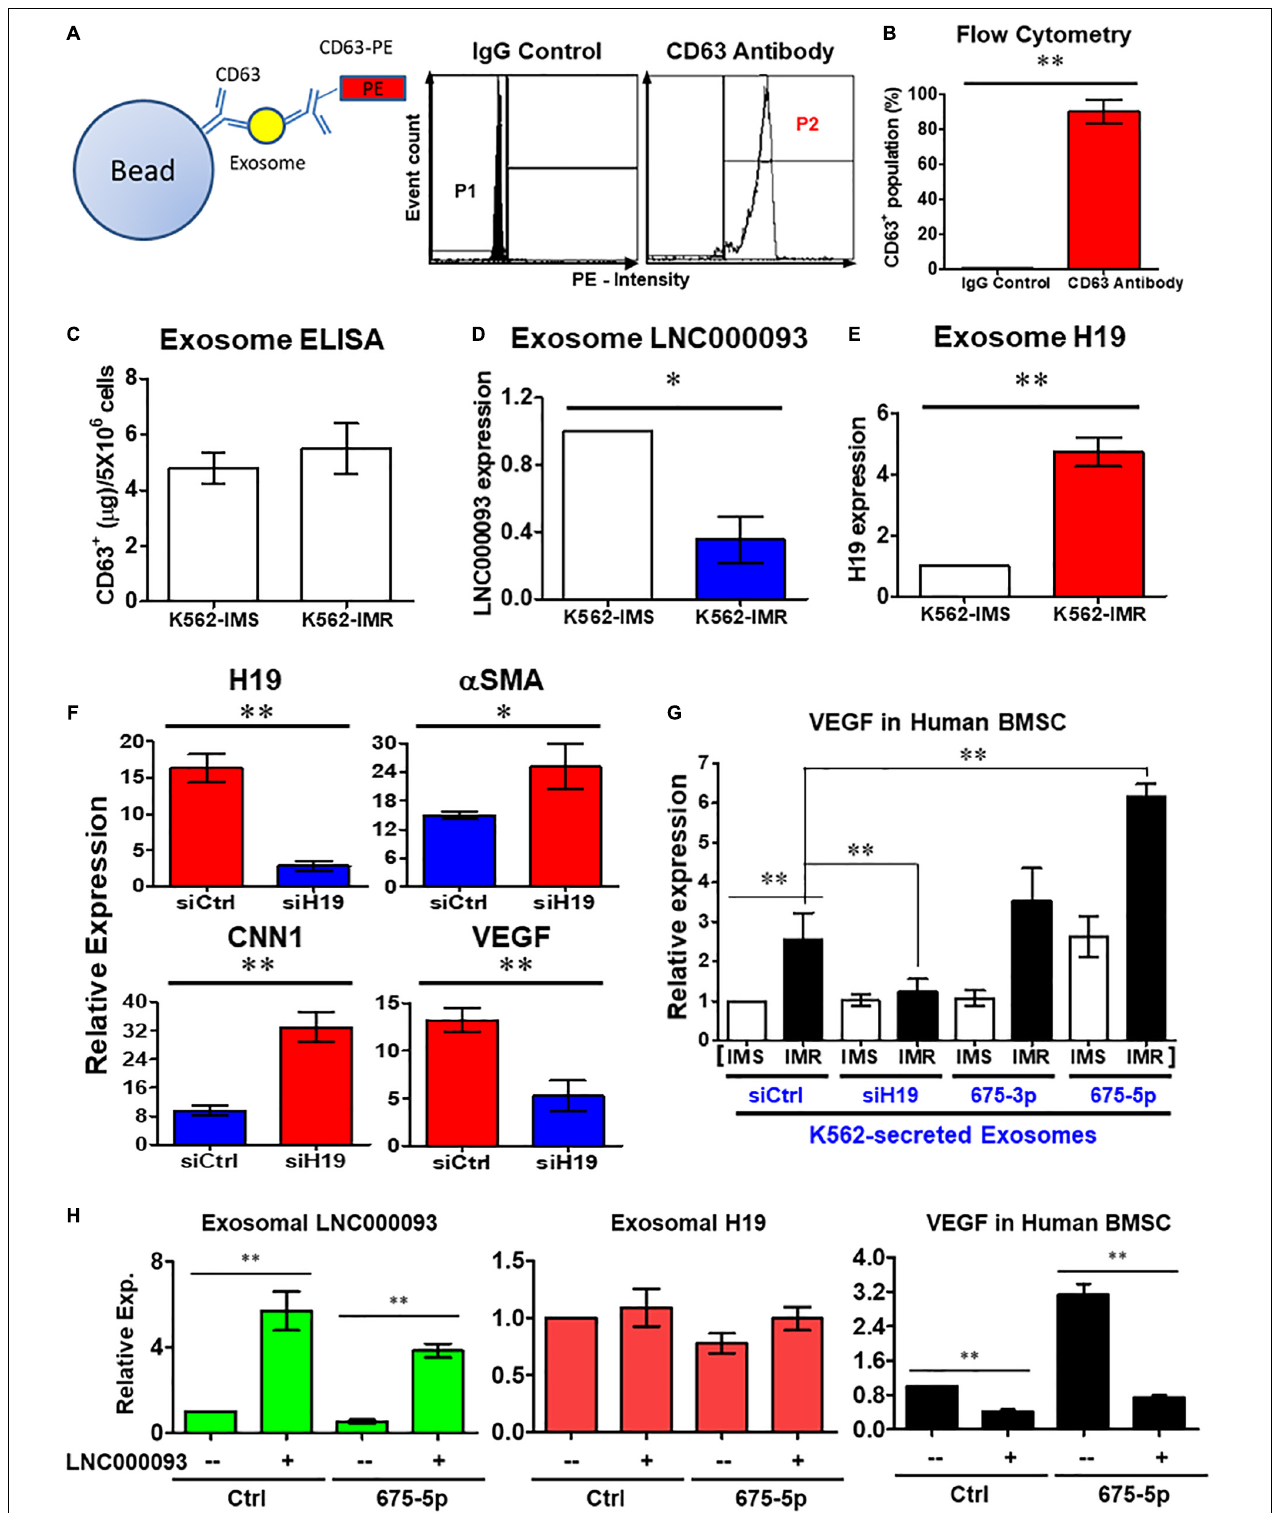
FIGURE 6 | Extrinsic regulatory role of LNC000093 was revealed for bone marrow stromal cells. (A,B) Flow cytometry assay revealed CD63 + -enriched exosomes were isolated from K562 with > 80% purity ( n = 3). The mean ± SD is shown for the results. ∗∗ P < 0.01. (C) ELISA assay showed the total amount of isolated